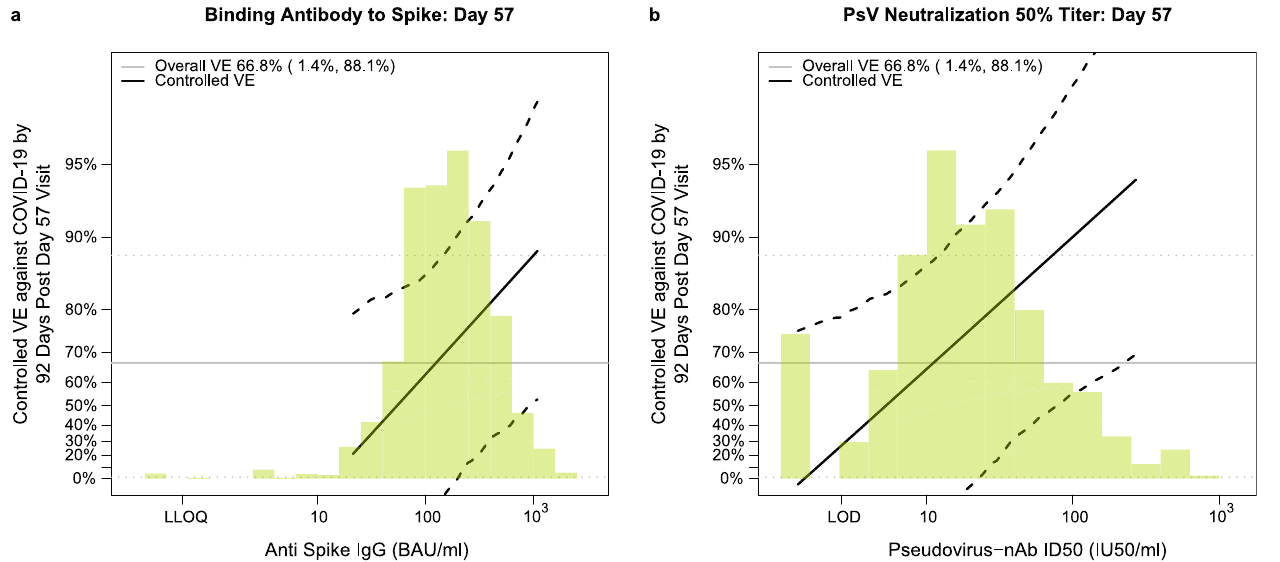
Fig. 5 Vaccine ef fi cacy by D57 antibody marker level in baseline SARS-CoV-2 negative vaccine recipients. Curves shown are for D57 ( a ) anti-spike IgG concentration or ( b ) pseudovirus (PsV)-nAb ID50 titer. The dotted black lines indicate bootstrap pointwise 95% con fi dence intervals. The green histogram is an estimate of the density of D57 antibody marker level and the horizontal gray line is the overall vaccine ef fi cacy from 7 to 92 days post D35, with the dotted gray lines indicating the 95% con fi dence intervals. Analyses adjusted for age and baseline risk score. Curves are plotted over the antibody marker range from the 2.5th percentile to the 97.5th percentile: 21.3 to 1088 BAU/ml for anti- spike IgG and 1.31 to 270 IU50/ml for PsV-nAb